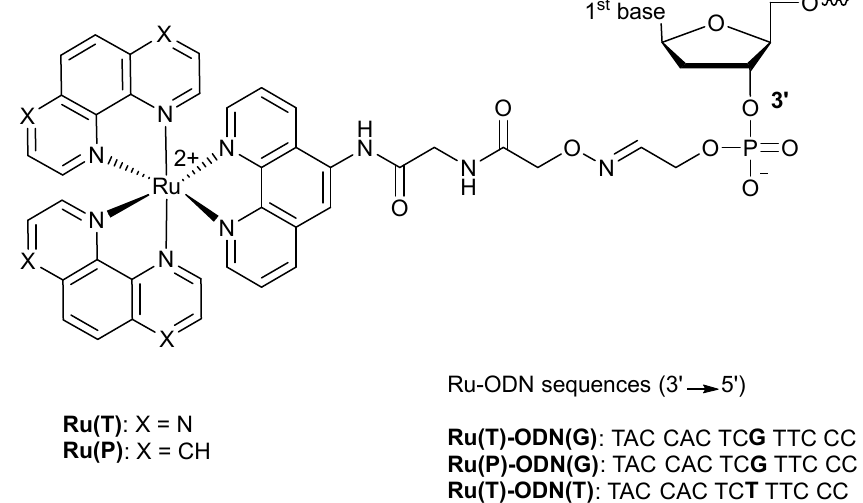
Figure 16. Structures of the Ru-ODN molecules [141].